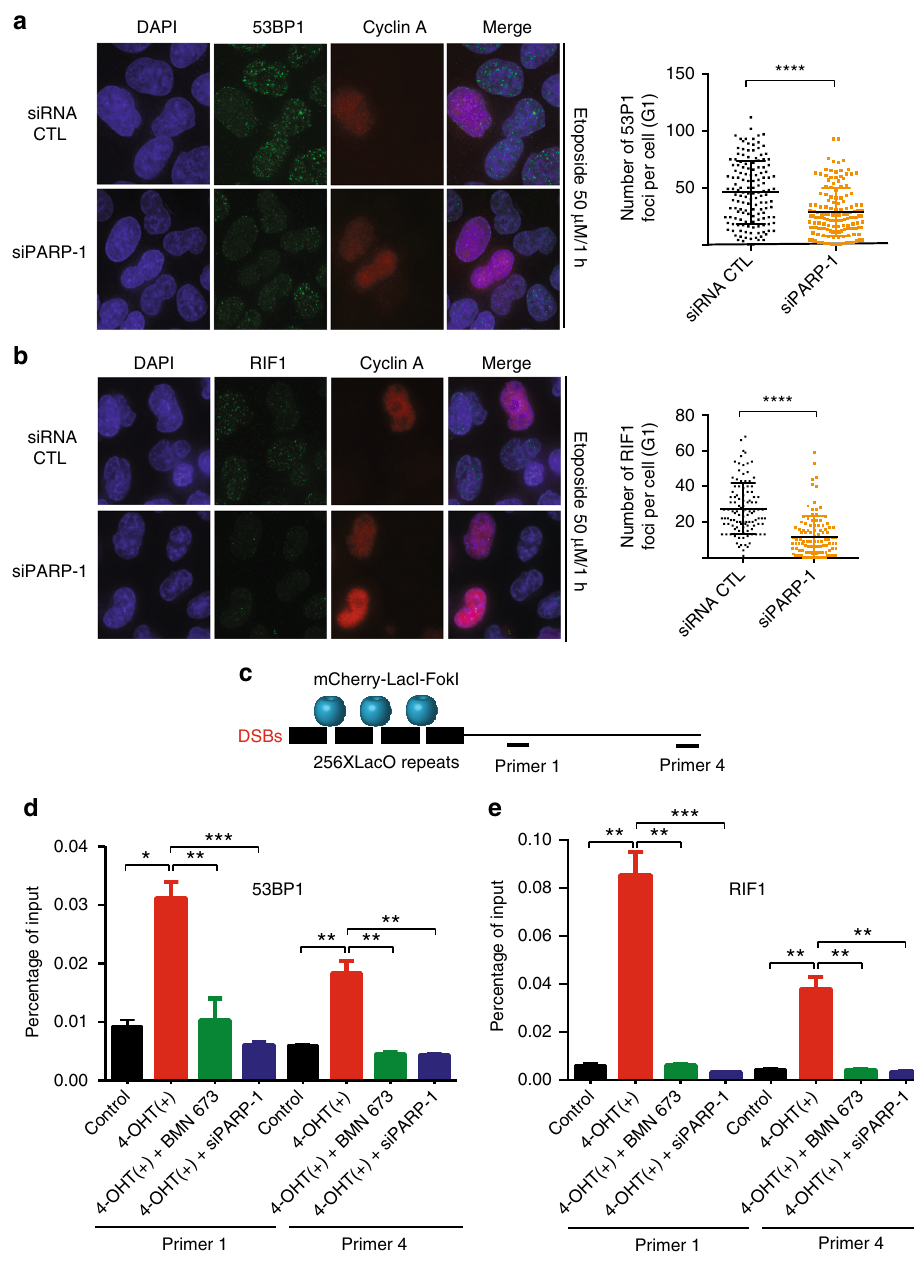
Fig. 3 Poly(ADP-ribose) polymerase-1 (PARP-1) inhibition reduces the accumulation of 53BP1 and RIF1 foci. a Etoposide-treated HeLa cells were either transfected with an small interfering RNA (siRNA) control or PARP-1 siRNA and subjected to immuno fl uorescence staining against 53BP1 or Cyclin A. The mean foci count was 46.05 for siRNA CTL and 28.42 for siPARP-1. Data show the mean ± s.d. **** p ≤ 0.0001 (Mann – Whitney U test). b